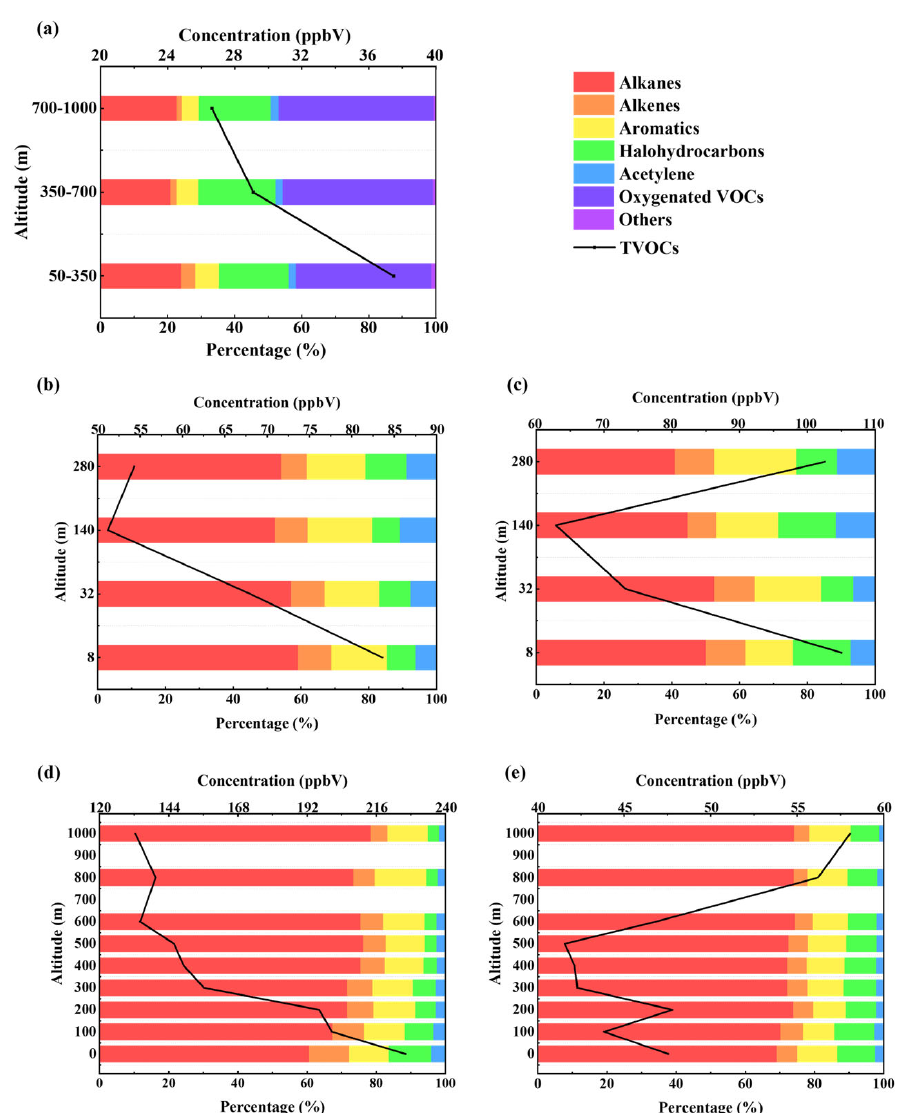
Figure 2. Vertical profiles and proportions of the average concentrations of VOCs in ( a ) late spring in Shanghai [98], ( b ) autumn in Beijing on clear days [18], ( c ) autumn in Beijing on haze days [18], ( d ) winter in North China Plain [2], ( e ) summer in North China Plain [2].